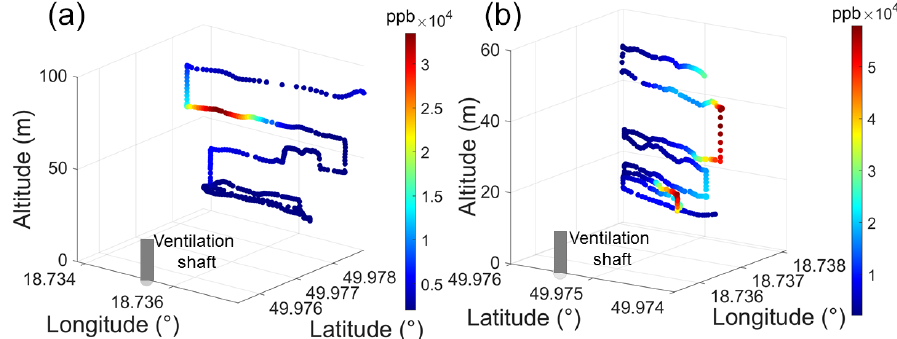
Figure 3. Samples of CH 4 concentrations on two flights: (a) Flight 6 and (b) Flight 15.